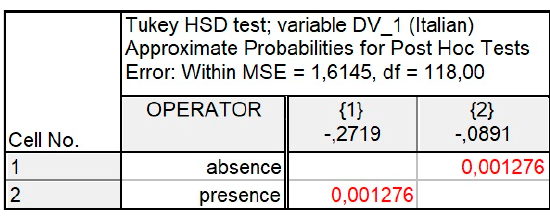
Figure 19. Operator post hoc results (Italian) .